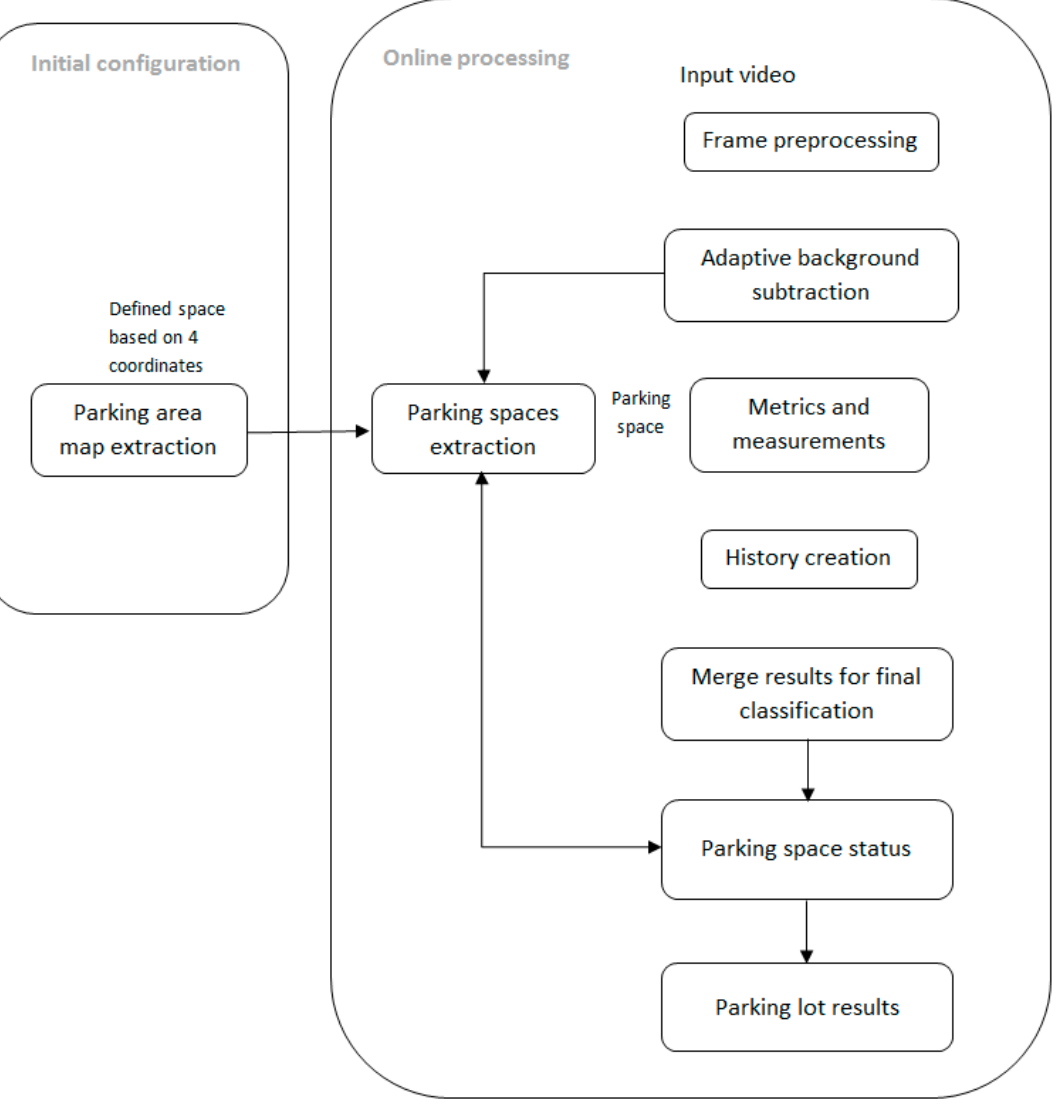
Figure 1. Parking lot occupancy system processing diagram.